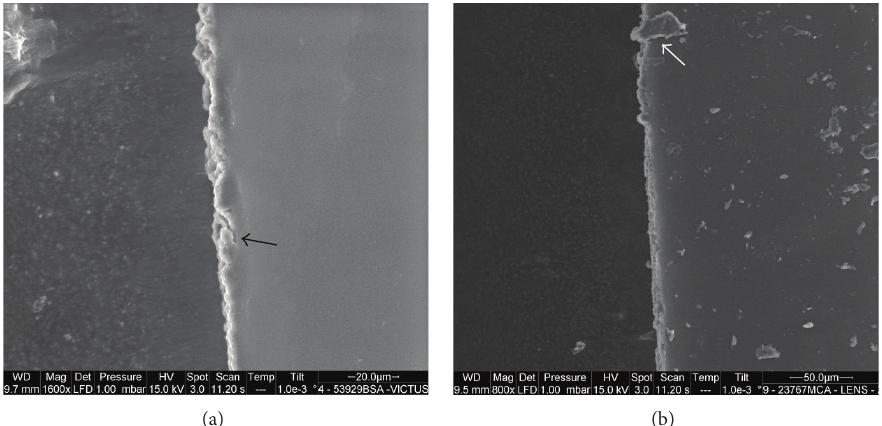
Figure 1: (a), (b) The Victus and LenSx capsulotomy cutting edges are shown, respectively. Linear cracks (black arrow) and tags (white arrow) are spread across the edges. The generation of these features may be consistent with eye movements during laser capsulotomy.